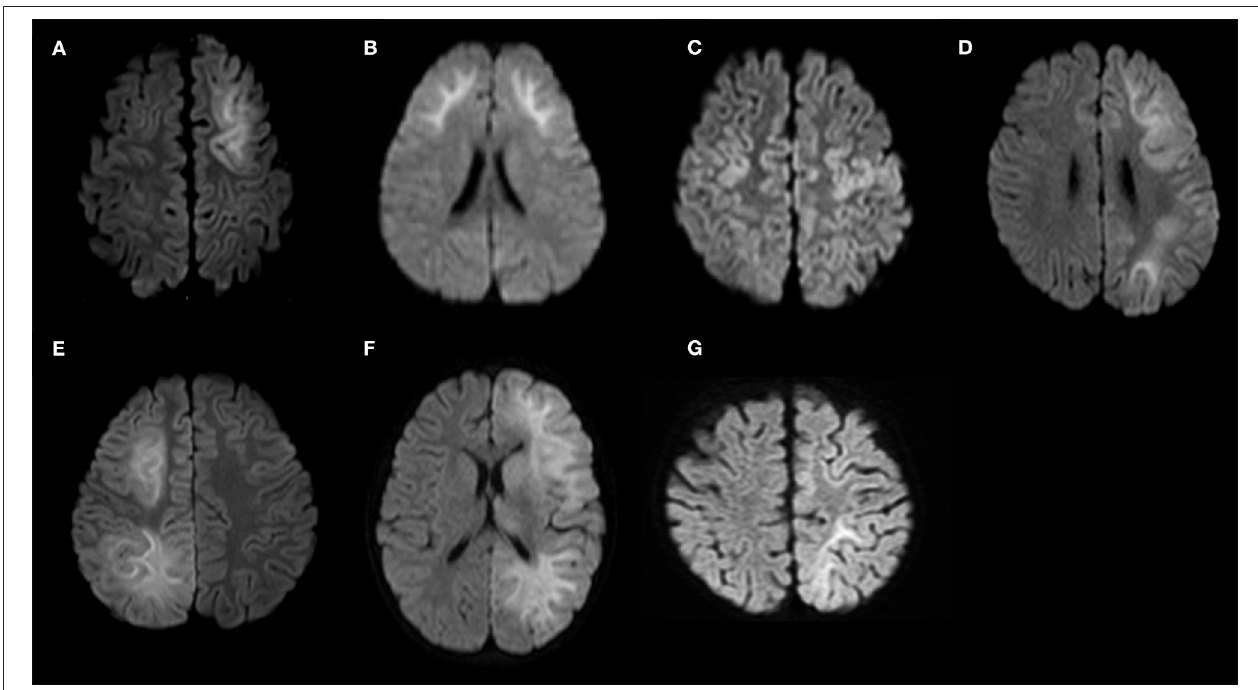
FIGURE 4 | Diffusion-weighted images of the study sample (continued). (A) Patient No. 9; (B) Patient No. 10; (C) Patient No. 11; (D) Patient No. 12; (E) Patient No. 13; (F) Patient No. 14; (G) Patient No. 15. Patients 9–11 show bilateral frontal lesions. Patient No. 11 does not show bilateral prefrontal lesions. Patients 12–15 show unilateral frontal